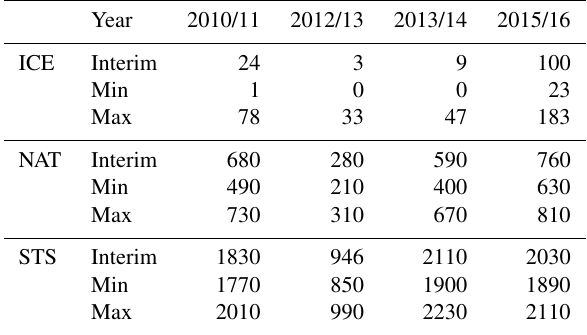
Table 1. Sum of the ICE, NAT and STS PSC areas (10 6 km 2 day)